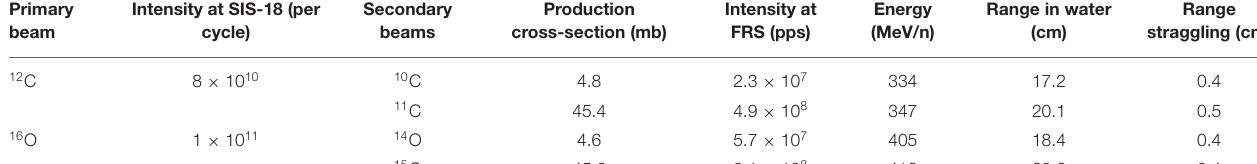
TABLE 2 | A MOCADI simulation of the RIB intensity at GSI FRS. Primary beam